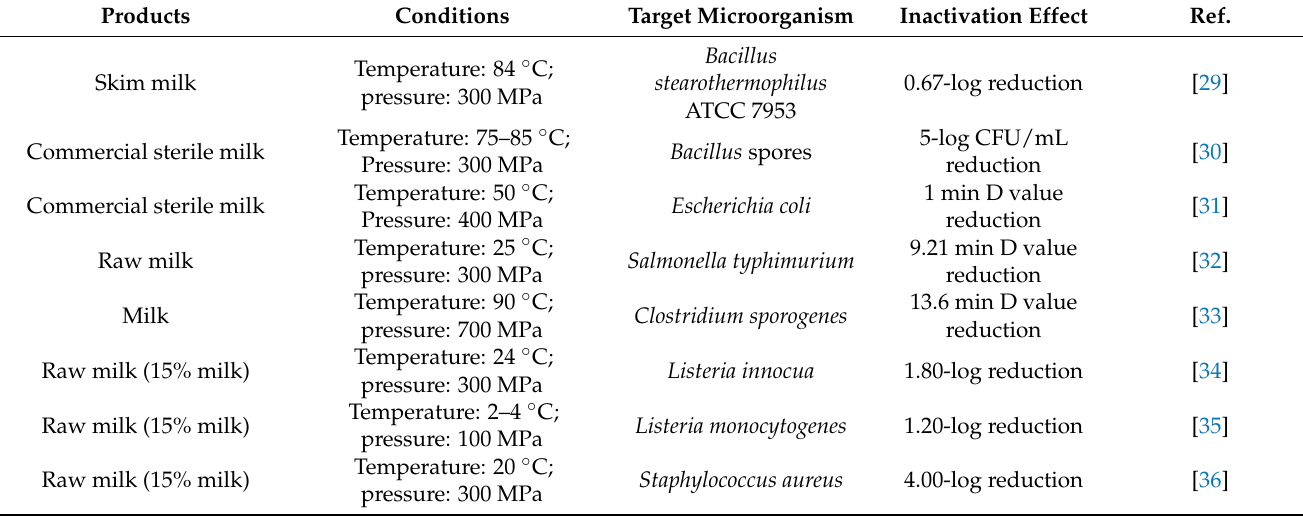
Table 1. Inactivation of microorganisms by high-pressure treatment in milk and milk products.